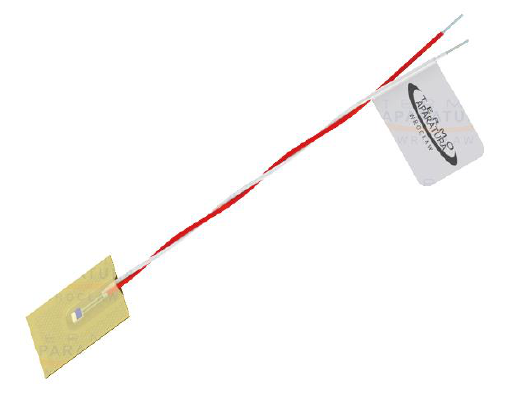
Figure 4. Sensor Pt-1000.